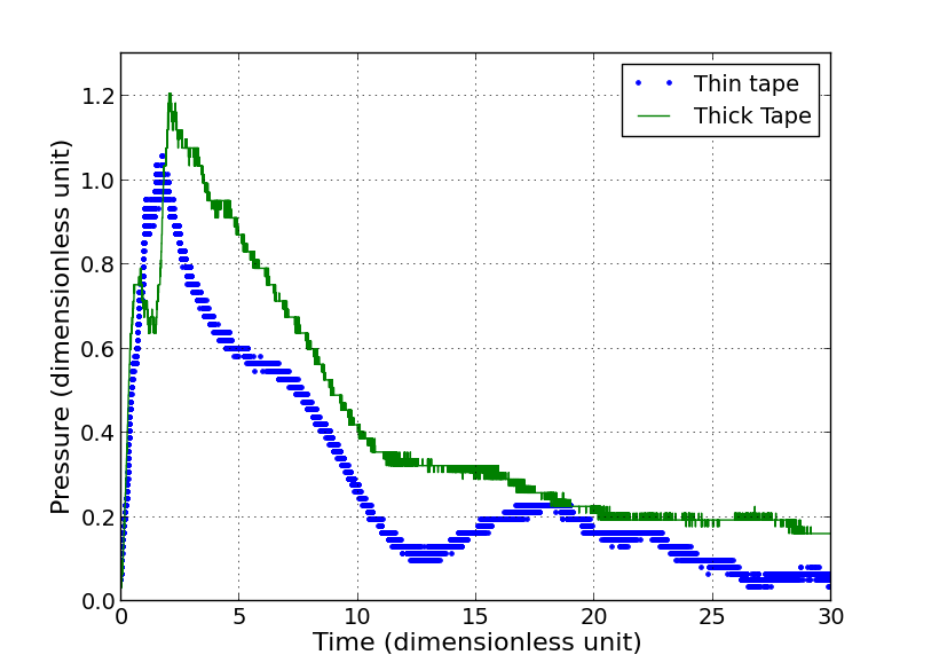
Figure 8. Measured pressure with sensor onto steel anvil using thin (30 µ m) and thick (300 µ m) double sided adhesive tape, from one detonating cord (dimensionless unit).